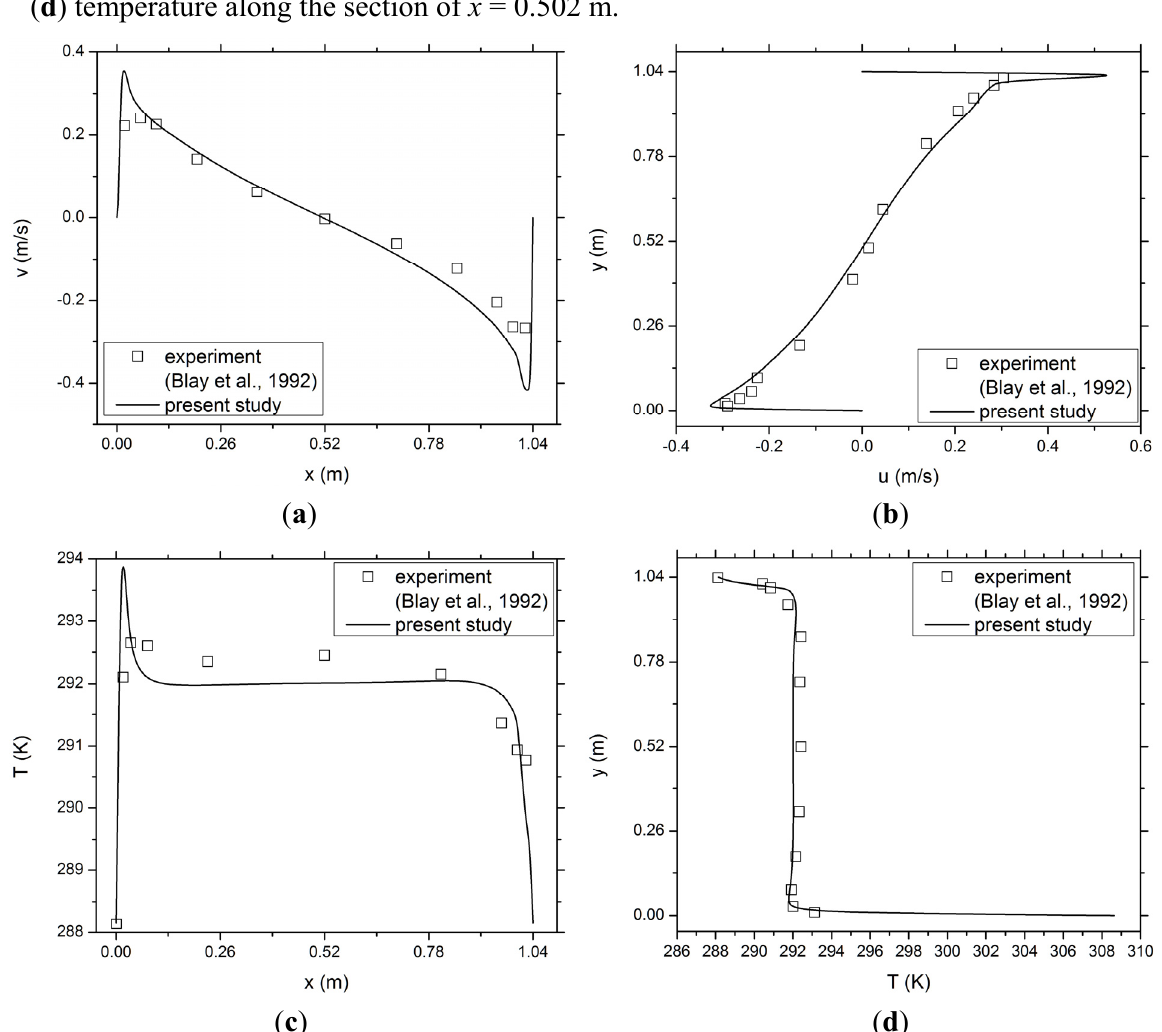
Figure 4. Comparison of modeling predictions with experimental data for the validation case: ( a ) vertical velocity along the section of y = 0.502 m; ( b ) horizontal velocity along the section of x = 0.502 m; ( c ) temperature along the section of y = 0.502 m; ( d ) temperature along the section of x = 0.502